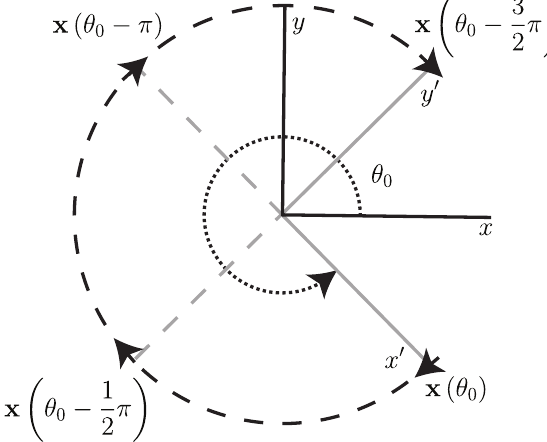
Figure 4. Schematic showing positions where velocity measurements were made and the position of the circle gradient frame to the reference